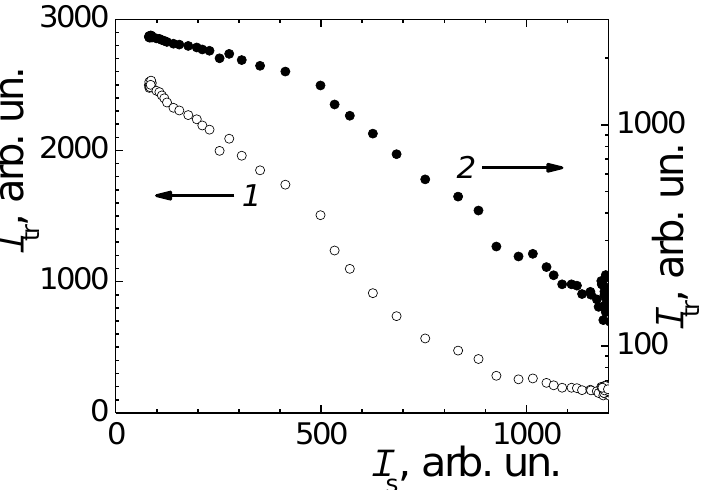
Figure 7. Dependence of the intensity I tr of the transmitted laser beam on the scattering intensity I s in linear (1) and semi-log (2) scales.